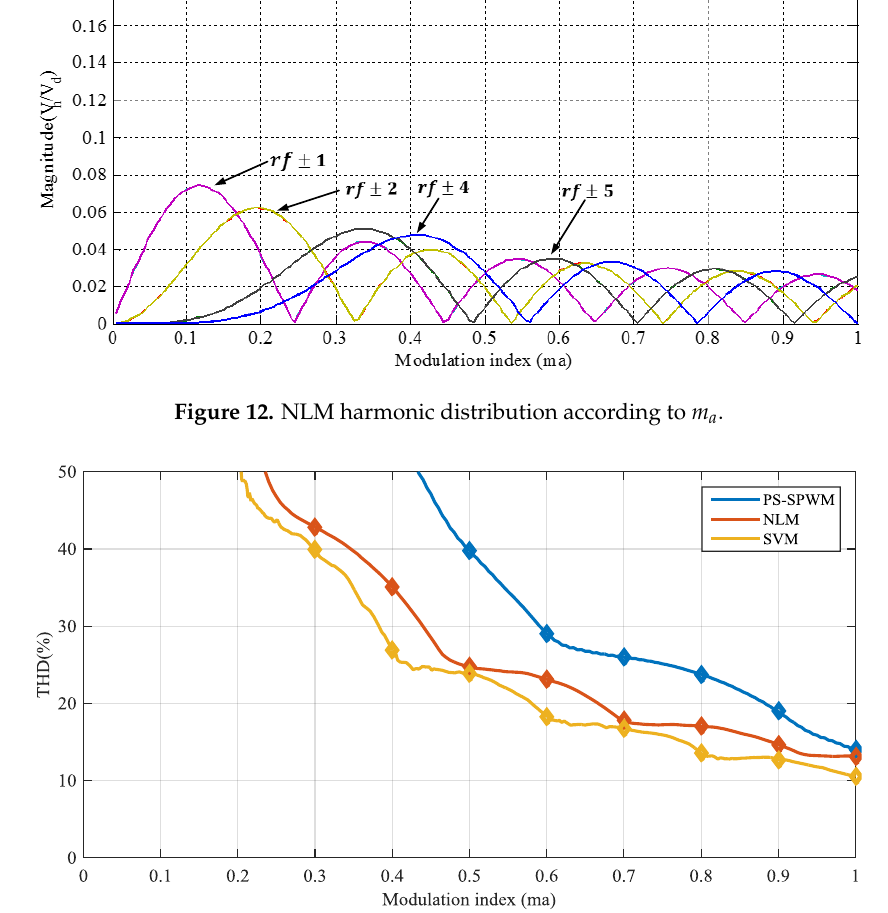
Figure 13. THD of the three modulation methods under study according to m a .